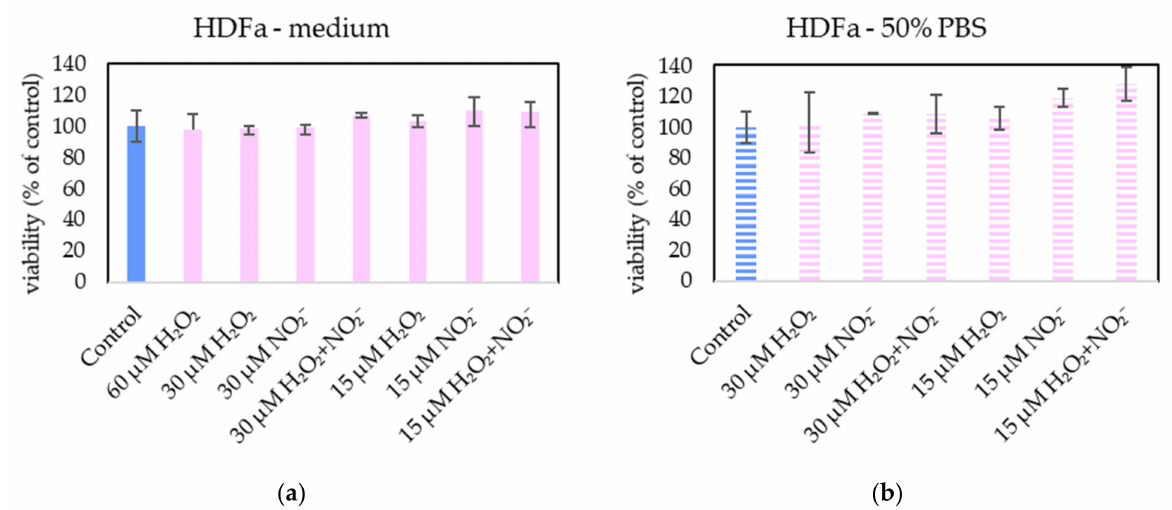
Figure 15. The effect of H 2 O 2 and NO 2 − on HDFa cells viability after 24 h incubation. H 2 O 2 and NO 2 − were externally added into 100% medium ( a ) or 50% PBS diluted with medium ( b ). No significant change was found. Viability was normalized to the control cells incubated in the